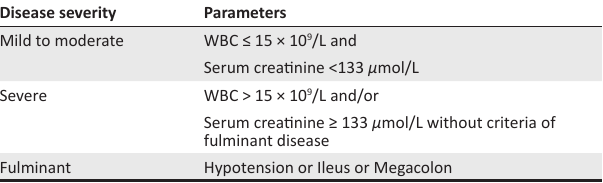
TABLE 3: Clostridioides difficile infection severity